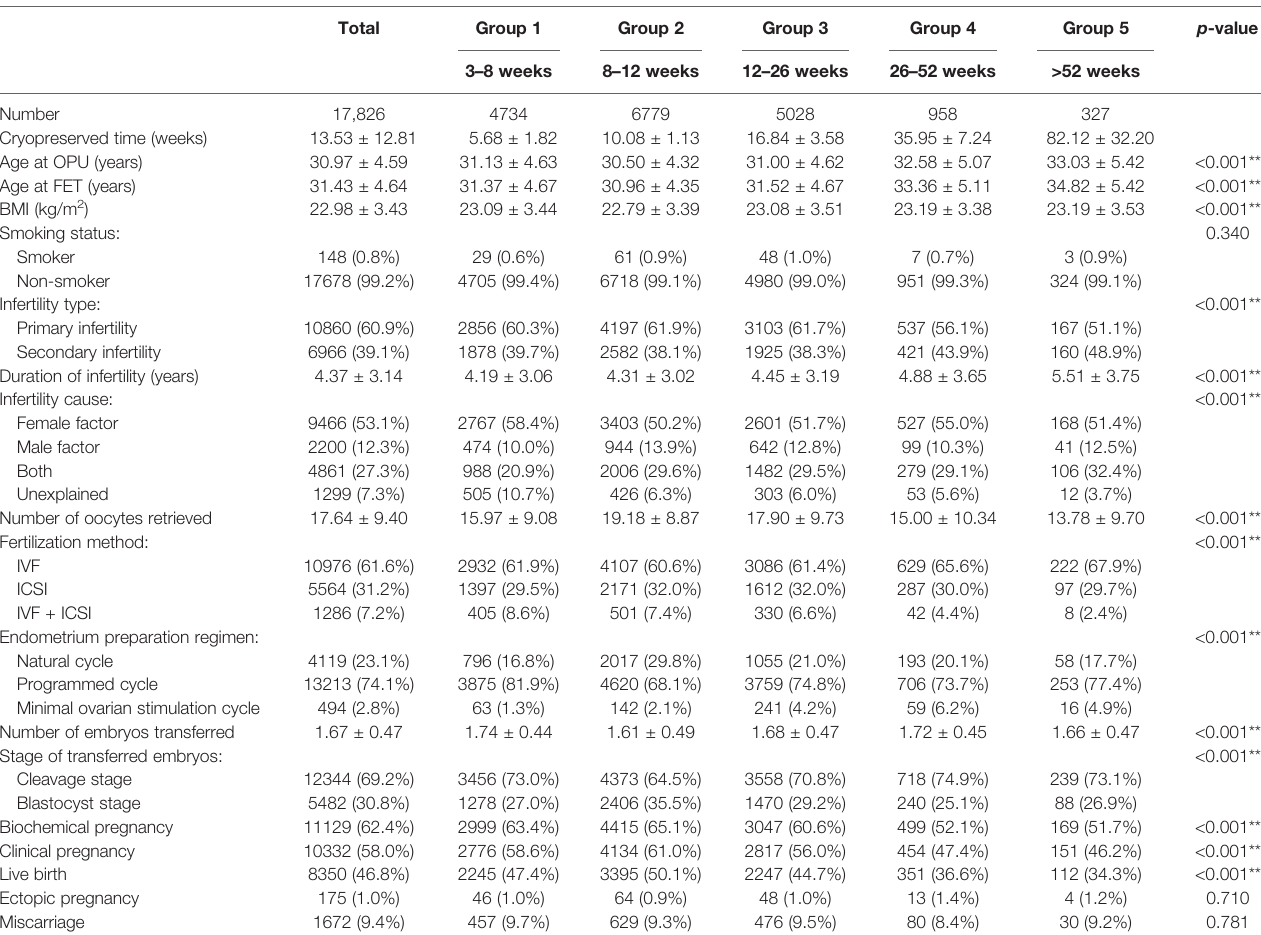
TABLE 1 | Demographic and clinical characteristics of the study